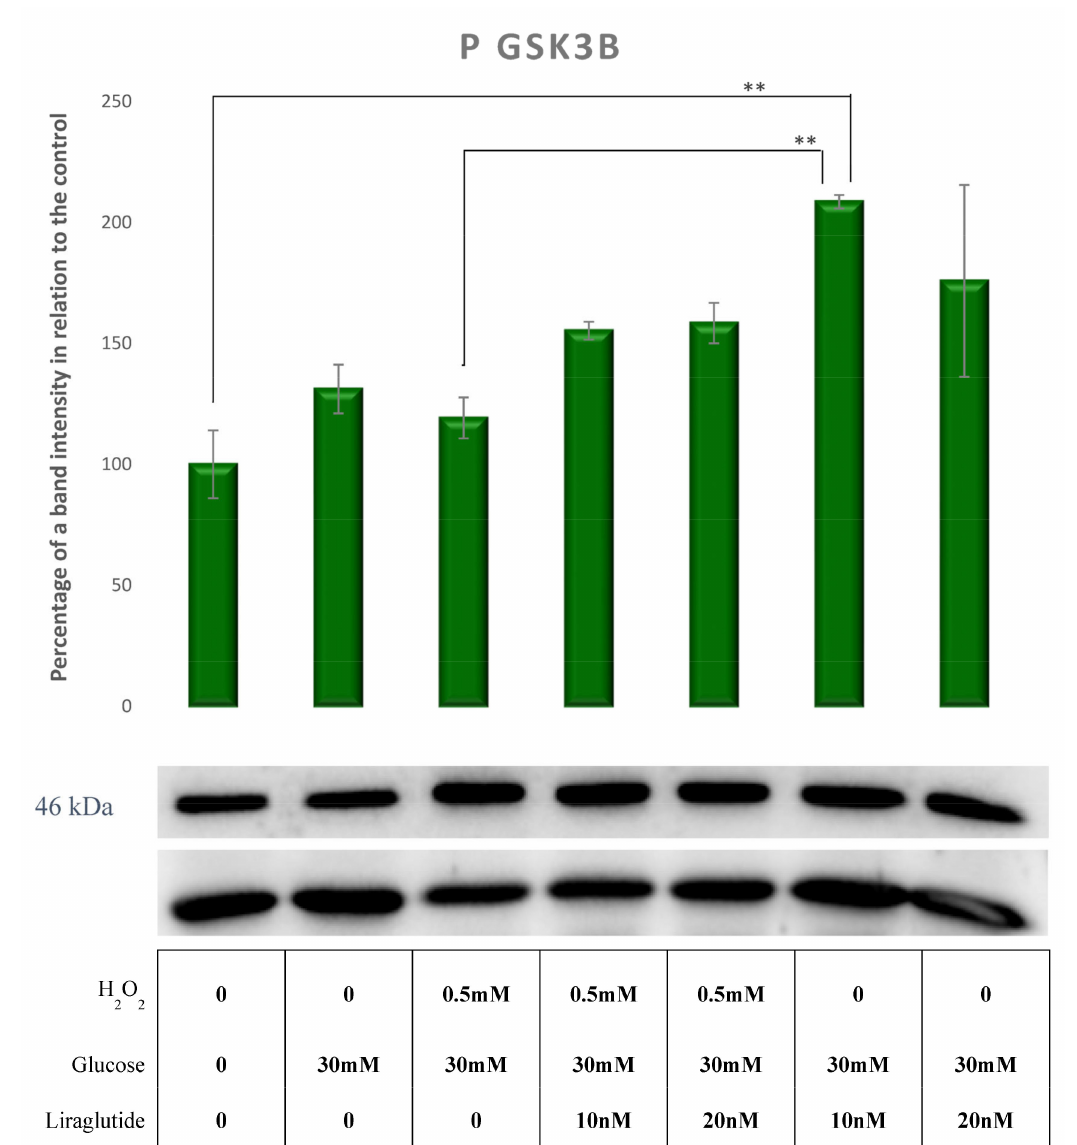
Figure 9. Protein expression in the LLC-PK1-treated cell line (control vs. HG30 and HG30/H 2 O 2 ; HG30 vs. HG30/Lira10 and HG30/Lira 20; HG30/H 2 O 2 vs. HG30/H 2 O 2 /Lira10 and HG30/H 2 O 2 /Lira 20) determined by Western blot. Glyceraldehyde 3-phosphate dehydrogenase (GAPDH) was used as an internal control. The data are shown as the means ± SD (standard deviation) from three independent biological replicates. One-way ANOVA F(6,20) = 4.589, p = 8.86 × 10 − 3 with Tukey HSD post hoc test; ** p < 0.01; Values underneath the x axis represent the amount of compound added in the experiment, and 0 represents that the compound was not added. Protein expression, pig proximal tubule cell line (LLC-PK1), HG (1.5 mM, 30 mM), H 2 O 2 (0.5 mM), Liraglutide (10 nM, 20 nM). NOX4 protein levels were not changed by the addition HG30 and HG30/H 2 O 2 com- pared to controls, but the cells’ exposure to HG30/H 2 O 2 caused a significant decrease of NOX4 compared to cells treated only with HG30 ( p < 0.01). NOX4 protein levels were significantly increased in cells treated with HG30/H 2 O 2 /Lira10 compared to those treated with HG30/H 2 O 2 ( p < 0.01), as shown in Figure